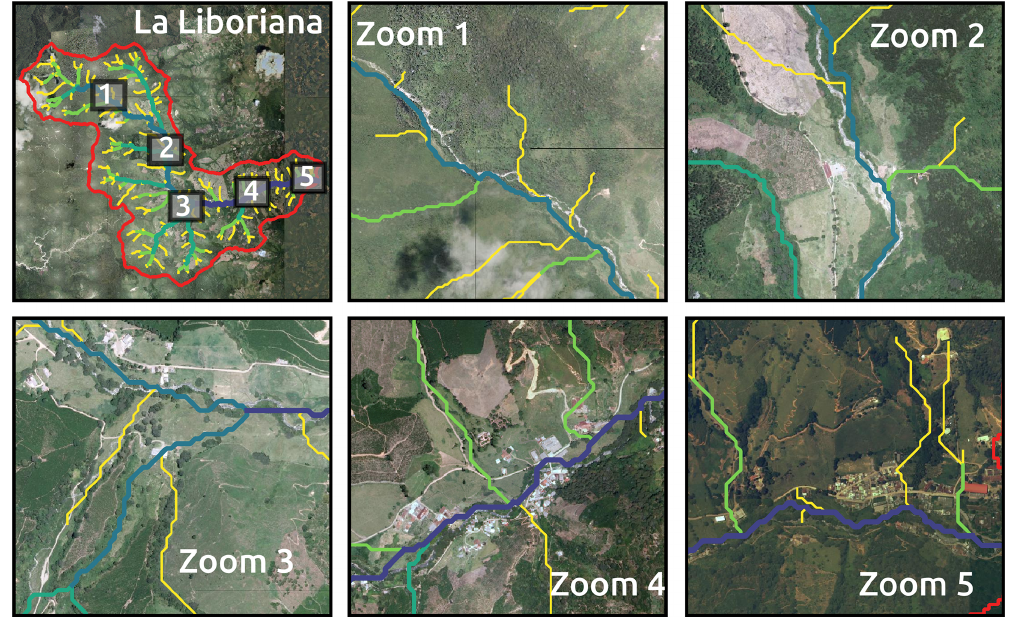
Figure 3. Aerial overview of La Liboriana basin (source: © Department of Antioquia). The top-right panel presents the entire basin, showing the locations of key regions detailed in the following panels, in zooms 1 to 5. The stream network is also presented, colored by order, from yellow to deep blue corresponding to orders 1 to 5.